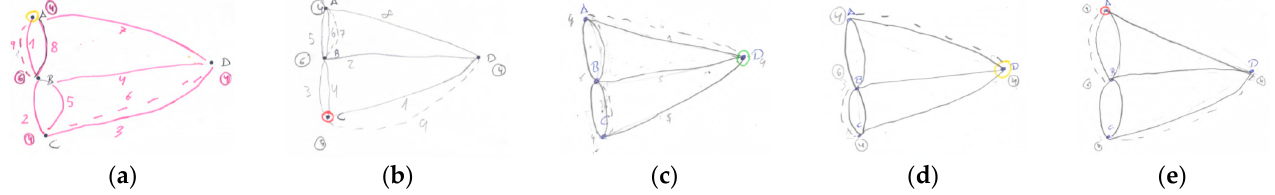
Figure 12. Graphs associated with Köningsberg bridges. Drawing made by participant: ( a ) A6; ( b ) A7; ( c ) A5; ( d ) A3; ( e ) A4.